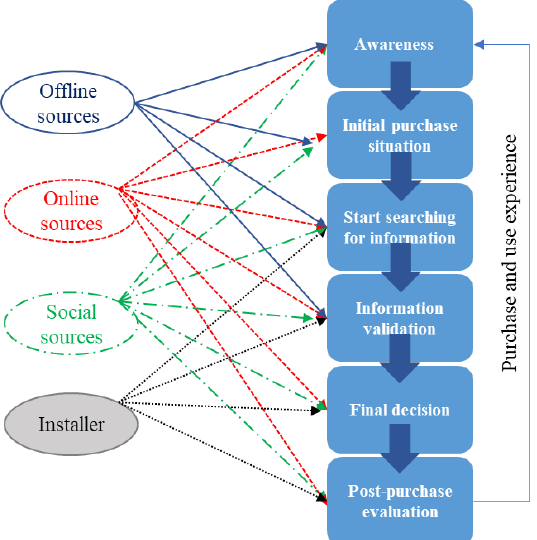
Figure 1. Proposed model of the purchase process of heating products and the influencing role of the social environment.